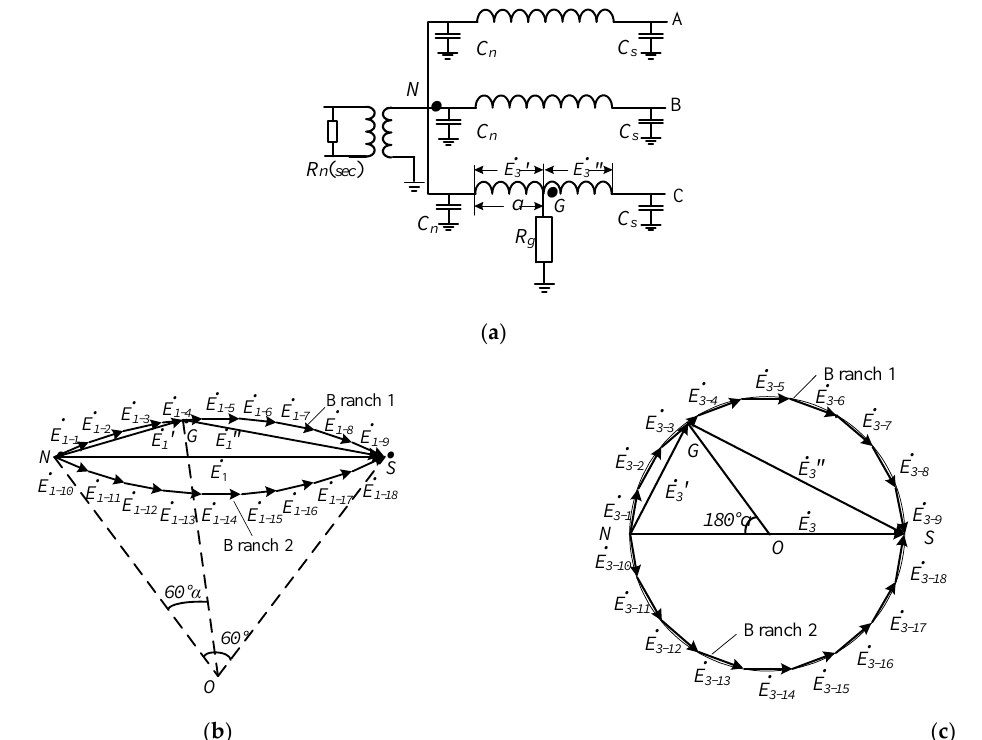
Figure 1. The stator ground equivalent circuit and its third harmonic voltage vector. ( a ) Single-phase grounding circuit of the generator stator; ( b ) The fundamental potential vector when stator grounded ( c ) The third harmonic potential vector when stator grounded.